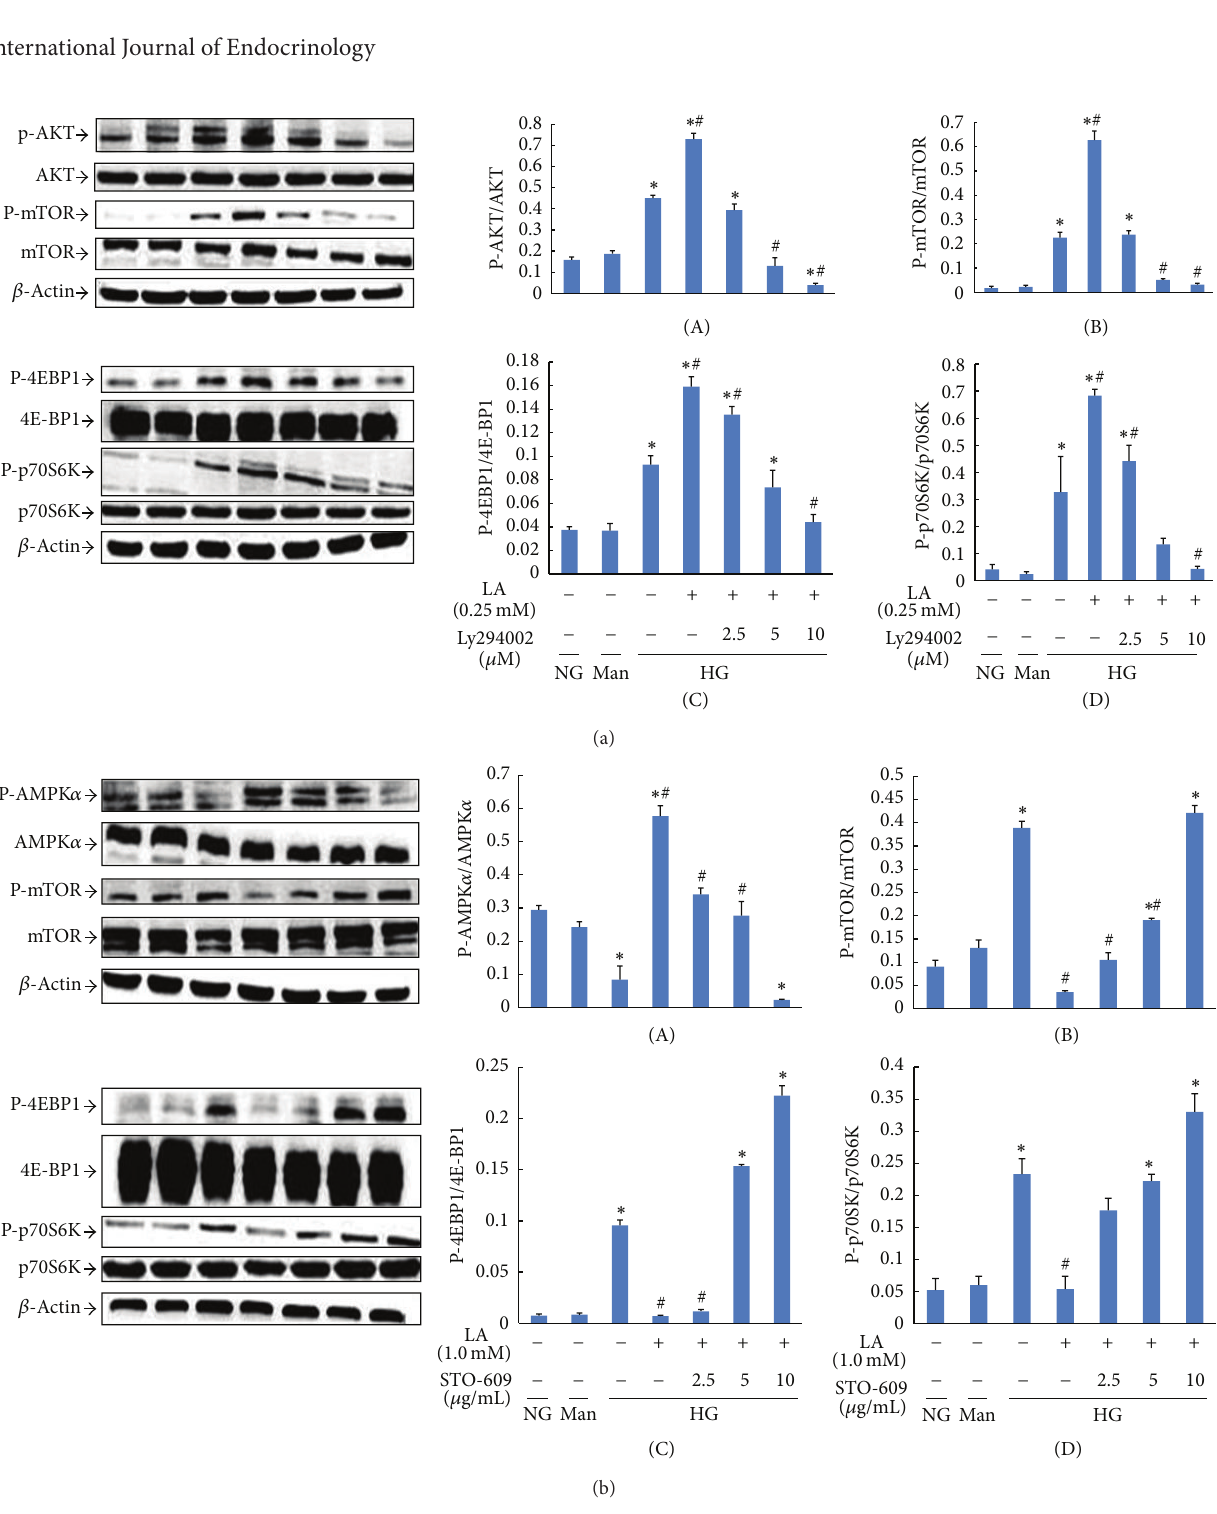
Figure 5: LY294002 prevented the phosphorylation of AKT, mTOR, p70S6K, and 4E-BP1 induced by 0.25 mM LA in high glucose-cultured MCs.Cellswerepreincubatedwithhighglucosemediumfor1 handthenstimulatedwithdifferentconcentrationsofLY294002inthepresence of 0.25 mM LA for an additional 24 h. The phosphorylation of AKT ((a) panel (A)), mTOR ((a) panel (B)), 4E-BP1 ((a) panel (C)), and p70S6K ((a) panel (D)) was determined by immunoblot analysis. STO-609 reversed the phosphorylation of AMPK, mTOR, p70S6K, and 4E-BP1 induced by 1.0 mM LA in high glucose-treated MCs. Cells were preincubated with high glucose medium for 1h and then stimulated with various concentrations of STO-609 in the presence of 1.0 mM LA for 24 h. The phosphorylation of AMPK ((b) panel (A)), mTOR ((b) panel (B)), 4E-BP1 ((b) panel (C)), and p70S6K ((b) panel (D)) in cells was determined by immunoblot analysis. 𝛽 -Actin was used as a control to ensure equal protein loading. Representative blots (left) and densitometric analyses (right) are shown. Values are given as mean ± SD; 𝑃 < 0.05 was considered statistically significant. Note: ∗ 𝑃 < 0.05 versus NG; # 𝑃 < 0.05 versus HG. Abbreviations: NG, normal glucose (5mM); Man (5mM glucose + 25 mM mannitol); HG, high glucose (30